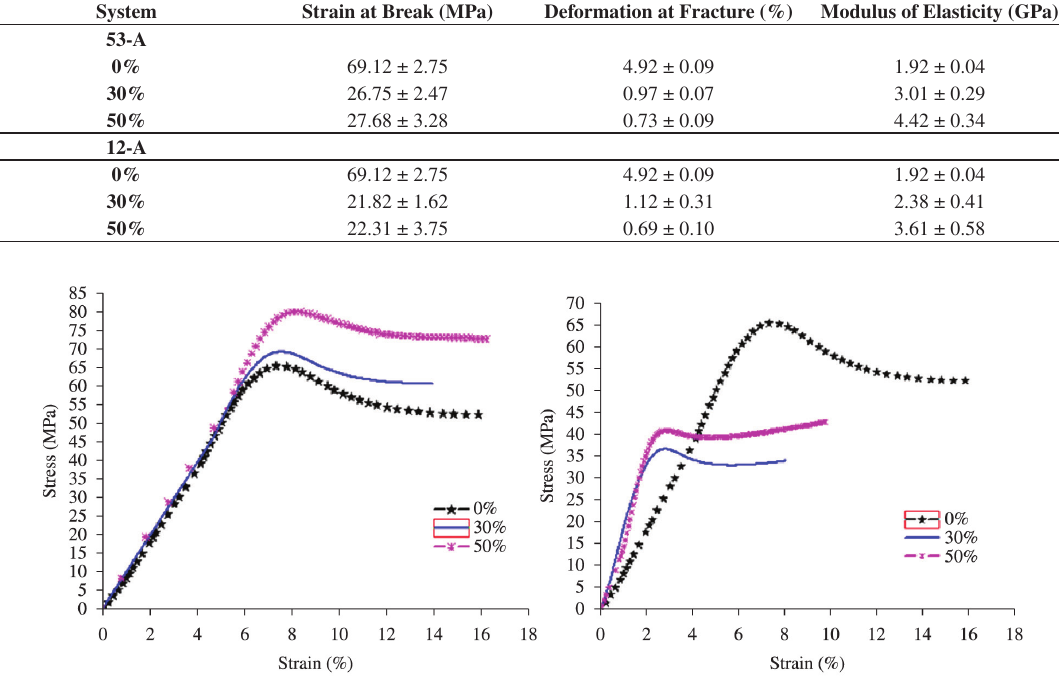
Figure 5. Tension-deformation curves illustrating the behavior under flexure of polymeric systems for: a) epoxy resin and 53-A, and b) epoxy resin and 12-A. Table 6. Results of the mechanical flexure tests.